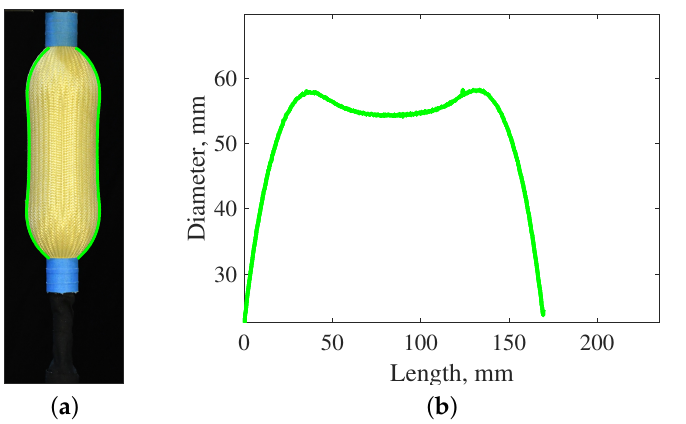
Figure 11. The resulting shape profile of the braid along the PAM’s length. ( a ) Step 5: Profile; ( b ) Diameter of shape profile with respect to